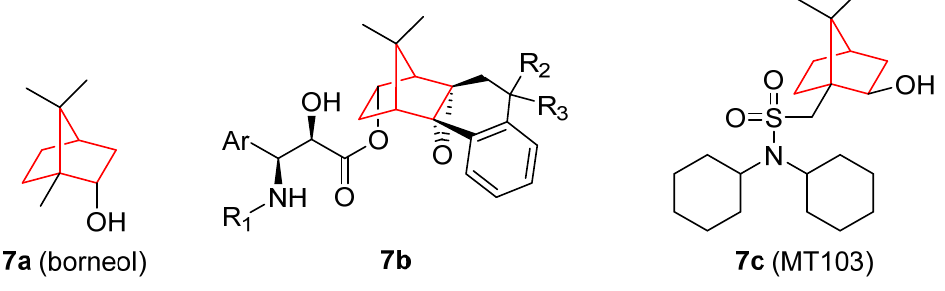
Figure 7. Borneol derivatives [65–77].